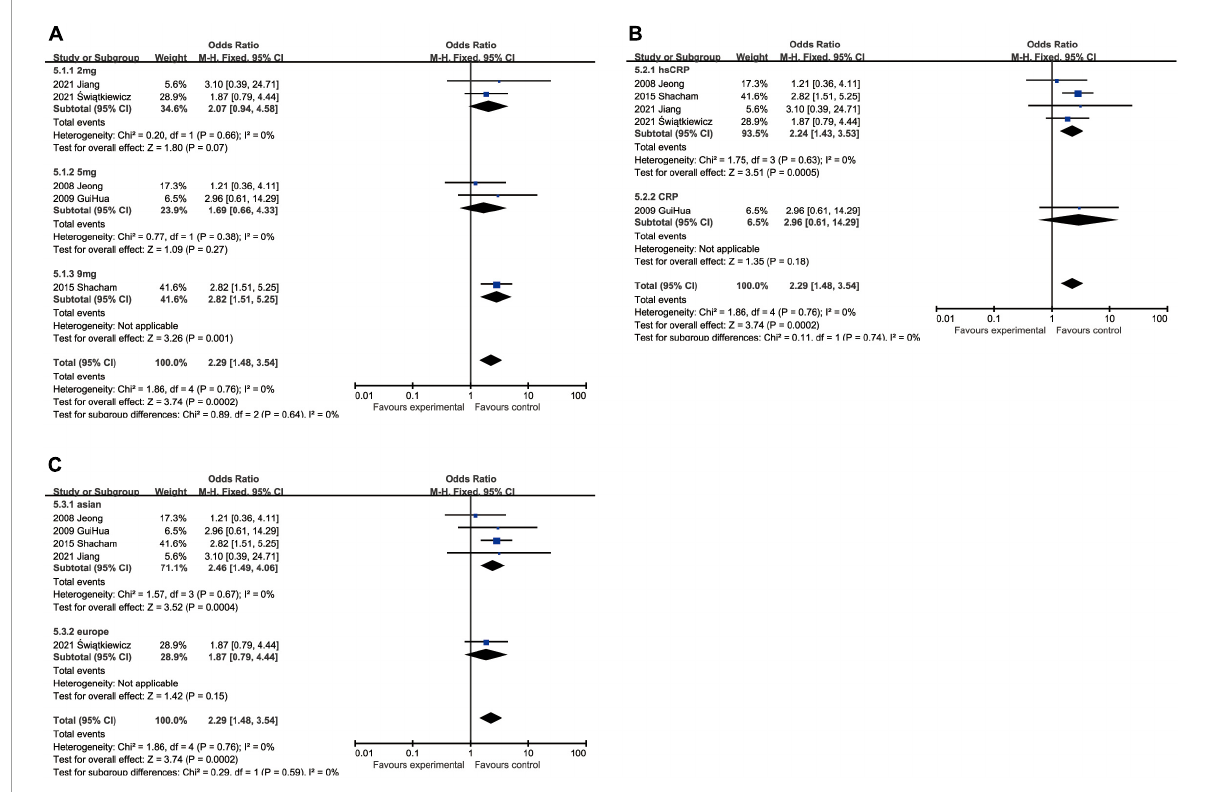
FIGURE6 Forrest plots of subgroup analysis assessing heart failure associated with increased CRP: (A) subgroups based on cut-off value of hsCRP; (B) subgroups based on CRP and hsCRP; and (C) subgroups based on